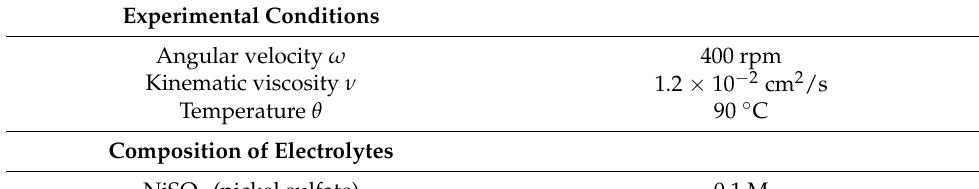
Table 2. Conditions assumed in [8] for performing our simulations.